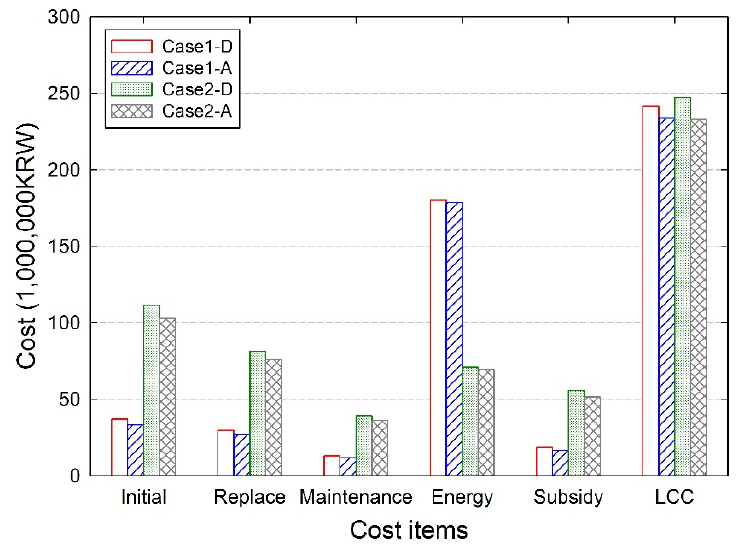
Figure 6. Comparison of the cost items for each